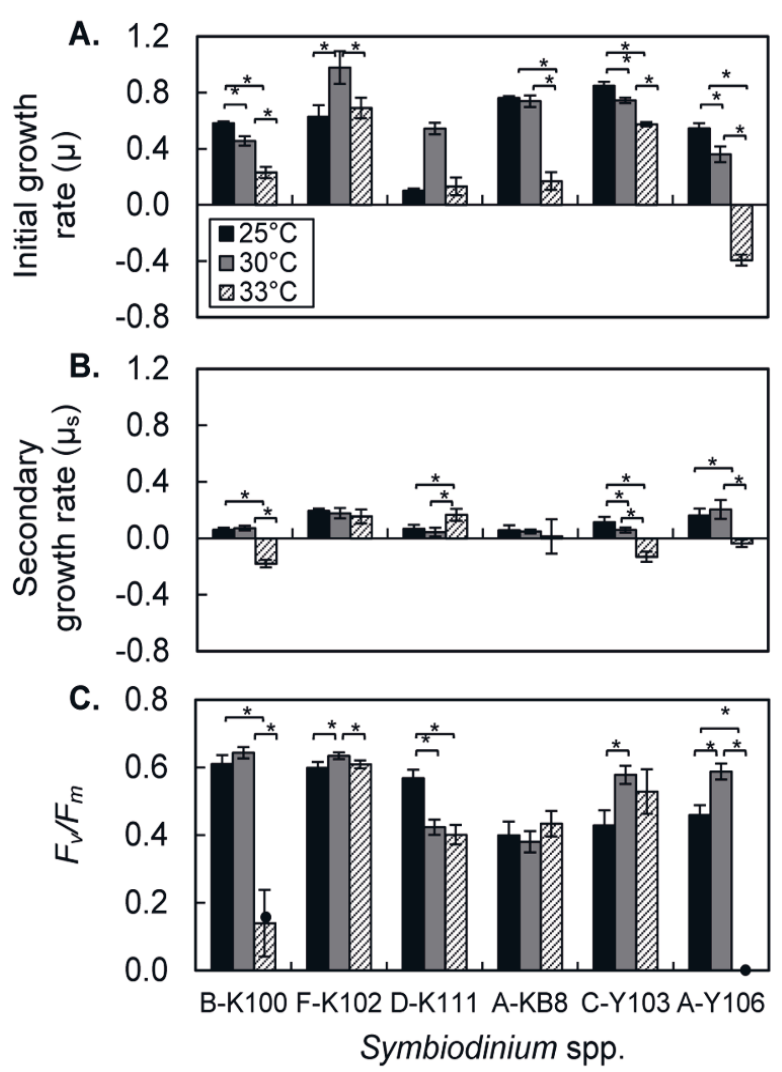
Figure 2. Growth rates and photochemical efficiencies ( F v /F m ) of six strains of Symbiodinium cells. ( A ). Initial growth rates ( μ ) of cells cultured at different temperatures; ( B ) Secondary growth rates ( μ s ) of cells cultured at different temperatures. ( C ). F v /F m measured after 14 days of temperature treatment. Filled circles in C indicate the F v /F m